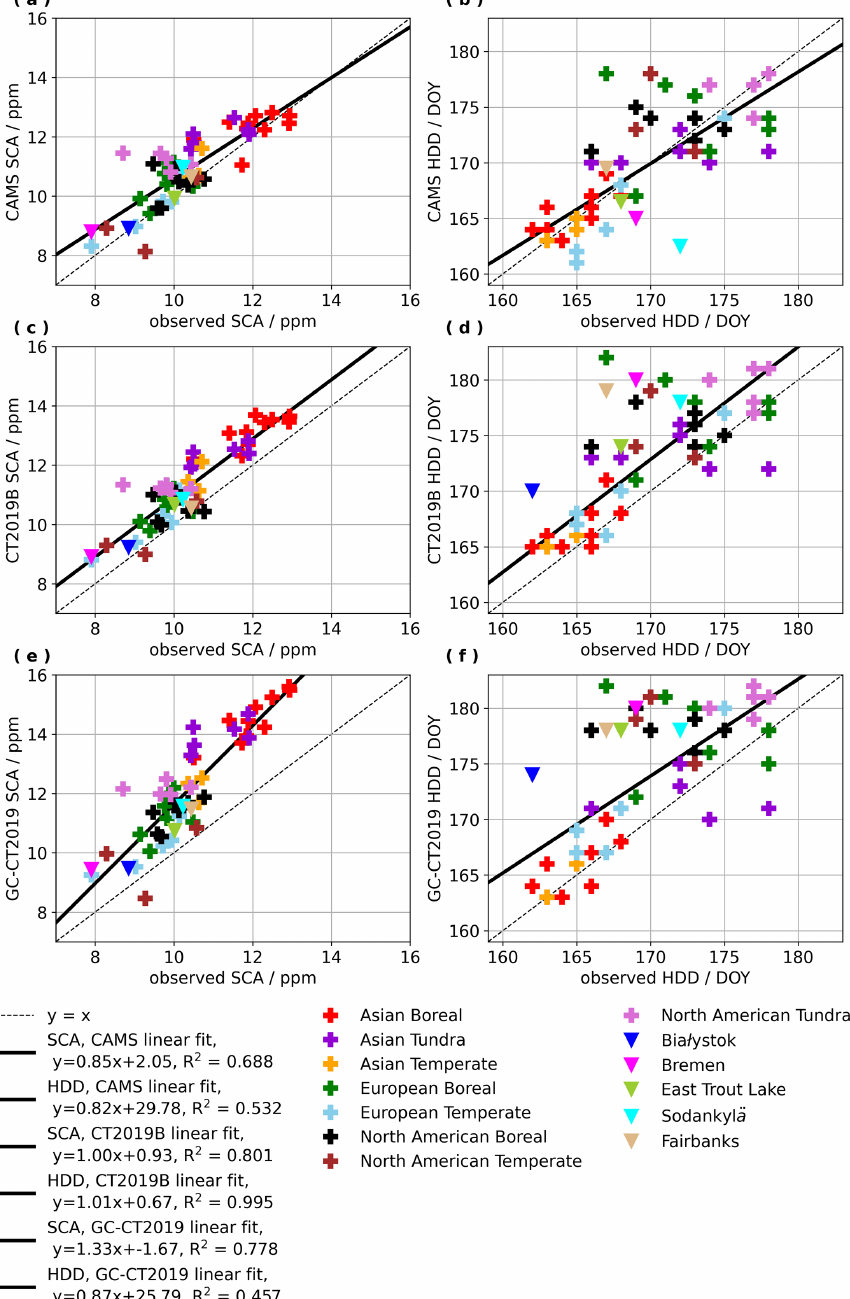
Figure 5. Plots of model-derived versus observed SCA and HDD using the model estimated from CAMS (a, b) , CT2019B (c, d) , and GC-CT2019 (e, f) , and using observations from OCO-2 within 5 ◦ latitude by 20 ◦ longitude zones and NNG observations at five ground